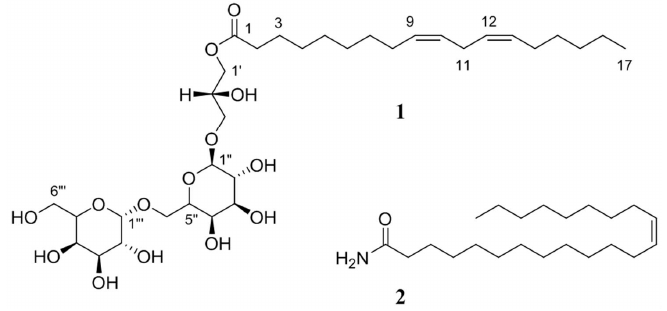
Figure 4. Isolated compounds from the main root of red ginseng.